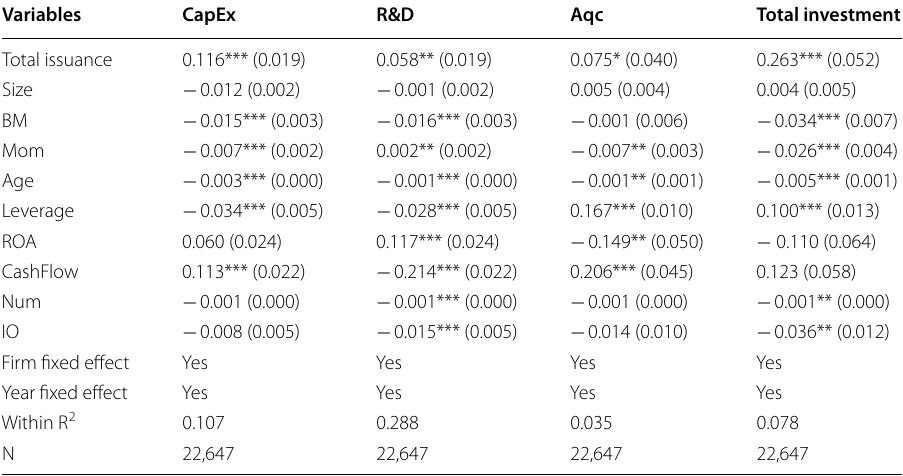
Table 4 Option-induced financing and